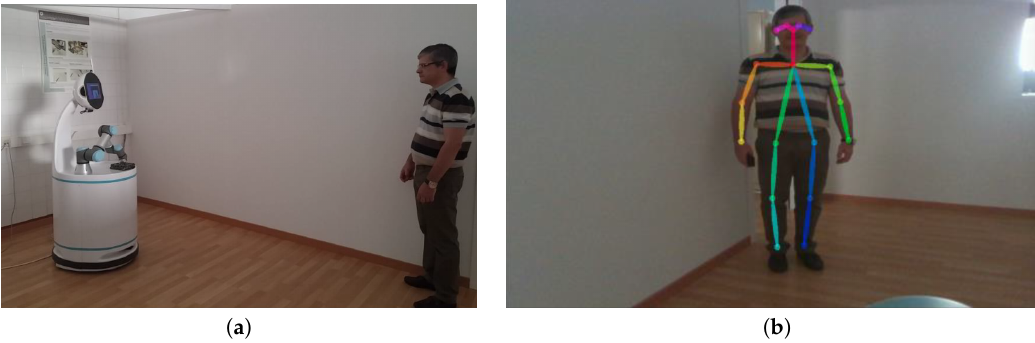
Figure 11. The experimental setup: ( a ) Robot and the person to estimate the pose; ( b ) the image captured with the OpenPose eighteen node body model superimposed.